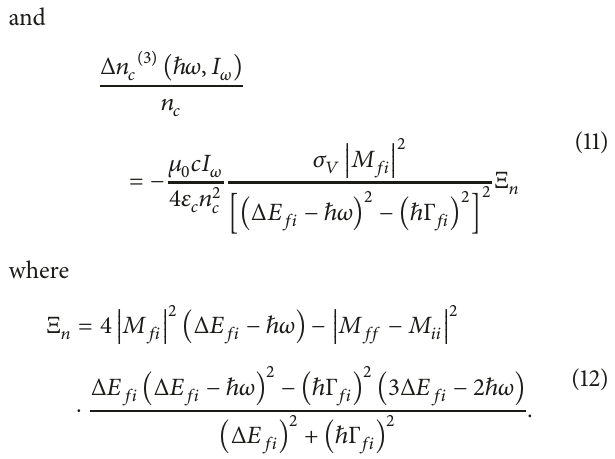
= ℎ𝜔 = 0 𝑚𝑒𝑉) and to 𝜂 1 0